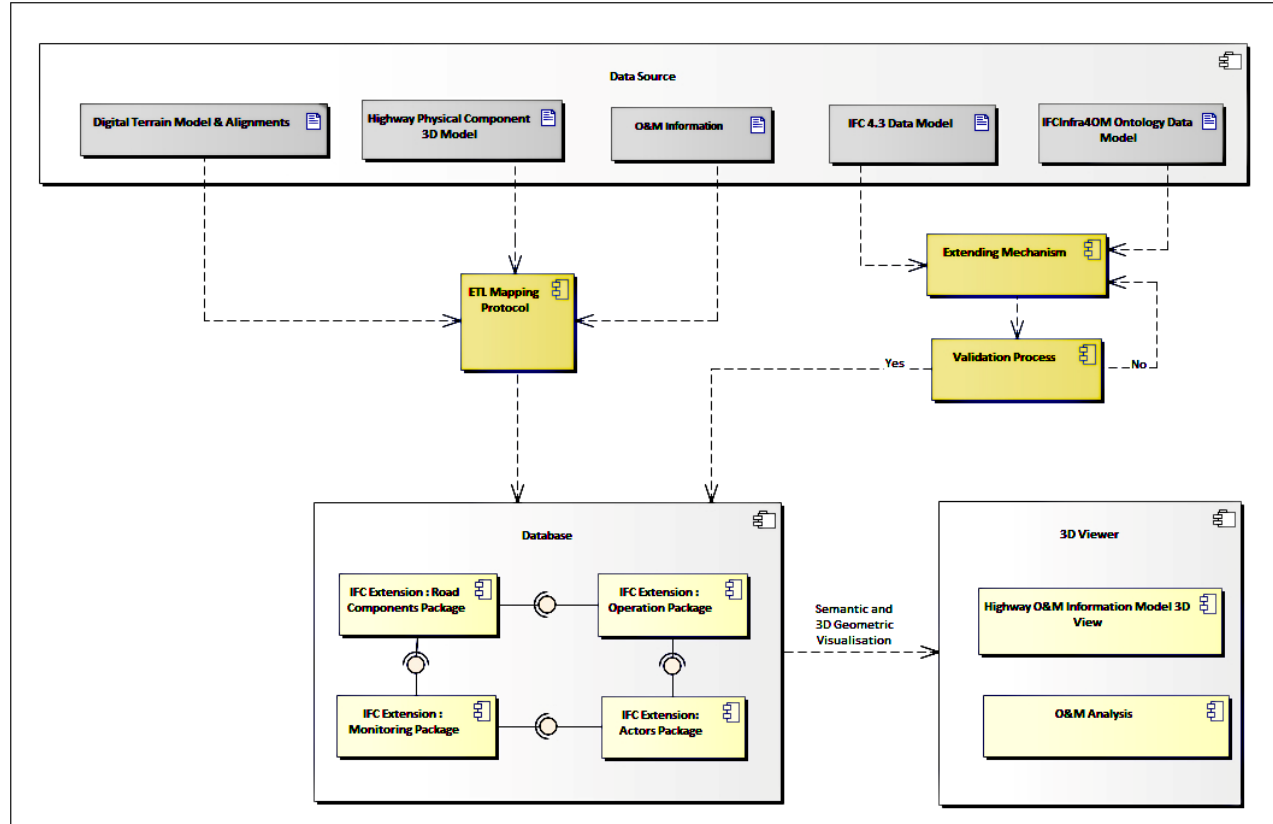
Figure 3. IFC extension by IFCInfra4OM ontology: implementation